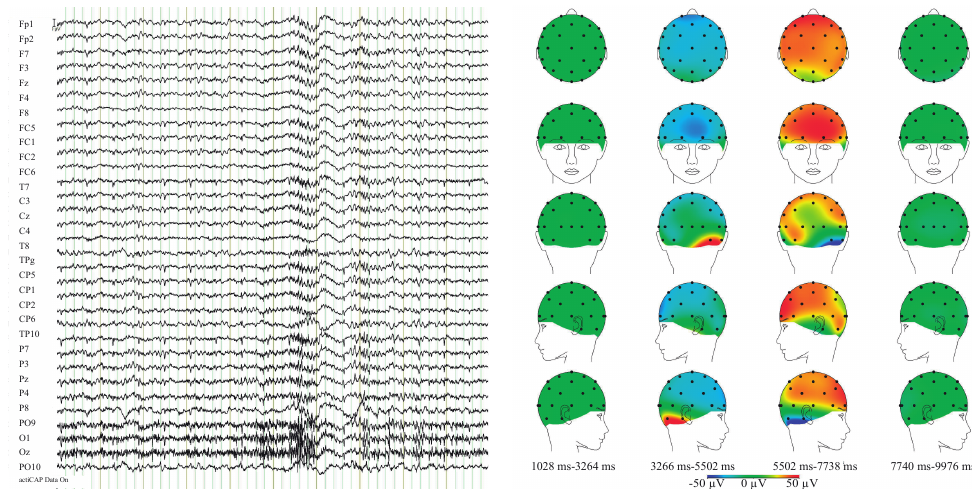
Figure 1. Raw EEG and scalp maps recorded.